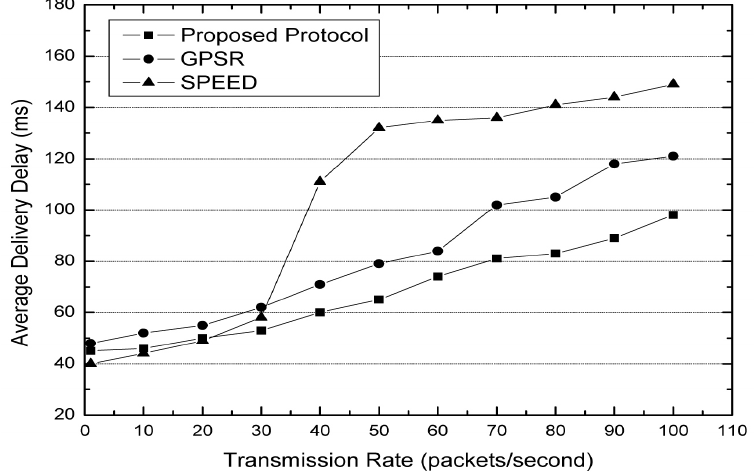
Figure 5. Average delivery delay with different transmission